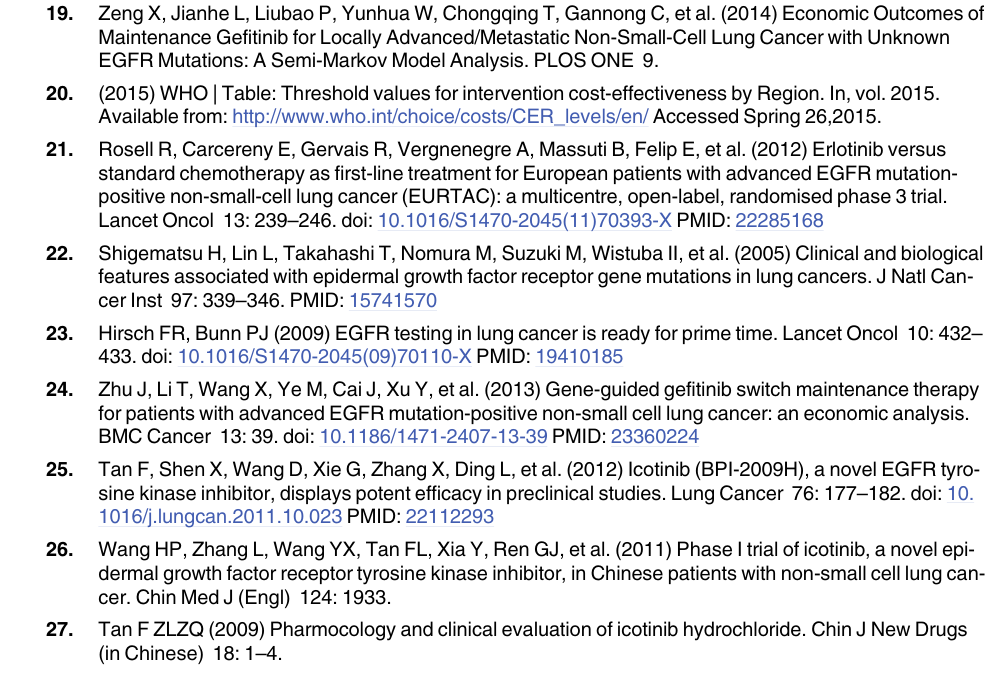
PLOS ONE | DOI:10.1371/journal.pone.0151846 March 25,